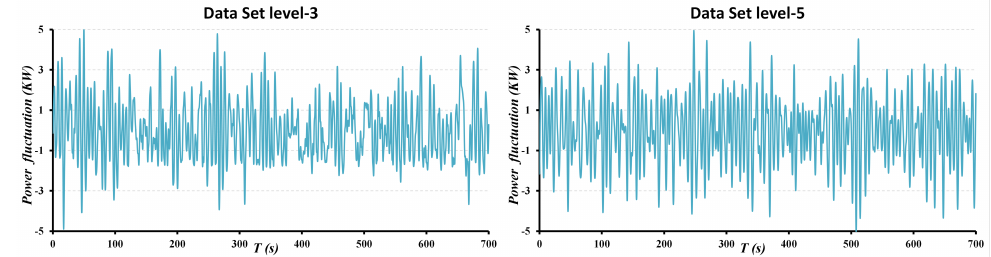
Figure 2. Two benchmark power fluctuation data